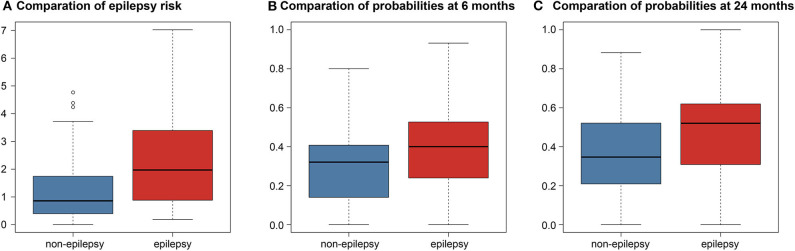
Boxplots comparison differences between predictions in the non-epilepsy and epilepsy groups. (A) Comparation of epilepsy risk. Boxplot of the predicted risk values of the Cox model corresponding to both the no epilepsy and epilepsy groups. (B) Comparation of probabilities at 6 months. Boxplot of the predicted probabilities of the logistic model at 6 months. (C) Comparation of probabilities at 24 months. Boxplot of the predicted probabilities of the logistic model at 24 months.